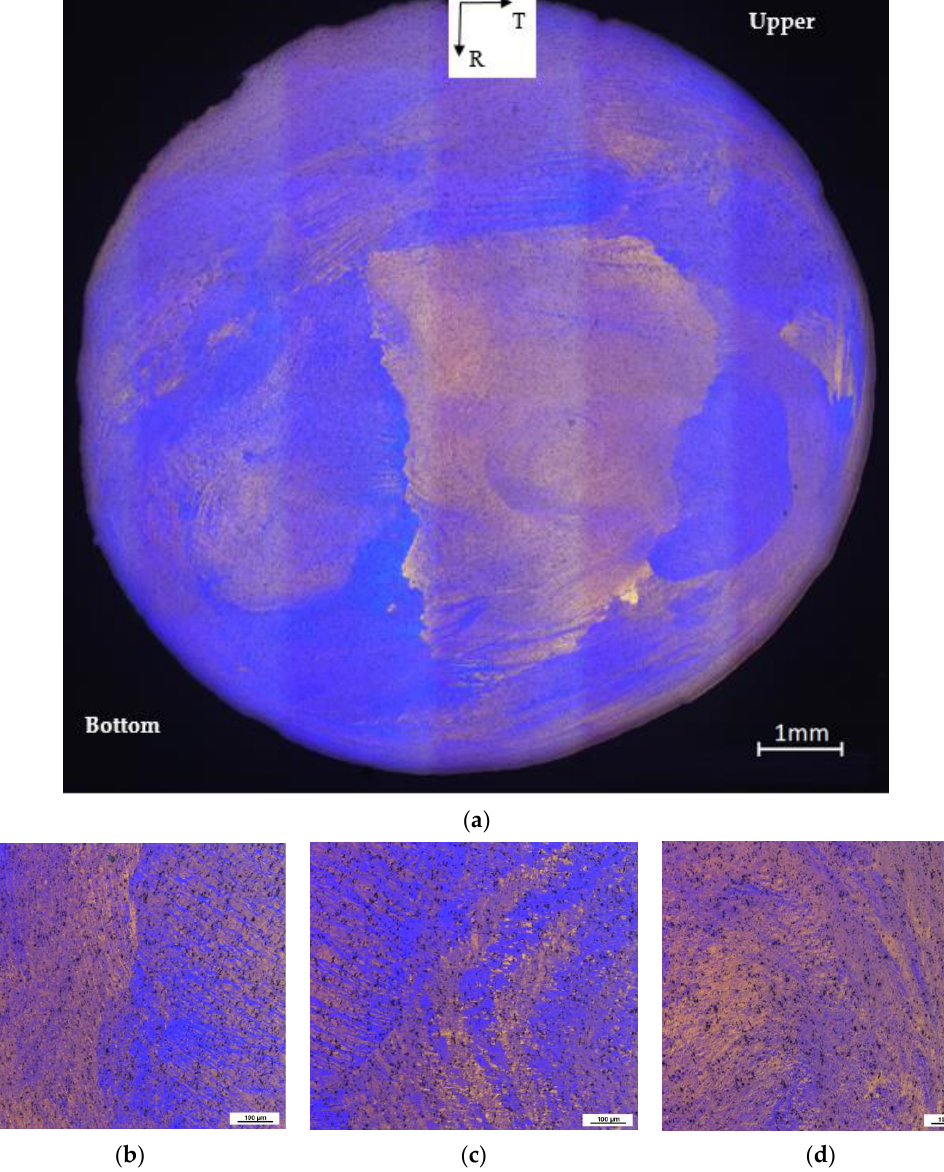
Figure 9. Light micrographs of the ECS material, taken on the TR section: ( a ) overall image of microstructure; ( b ) upper and ( d ) bottom surface region showing a mixture of thin grains in the surface vicinity; and ( c ) massive grains in the center. Barker’s etching was used.